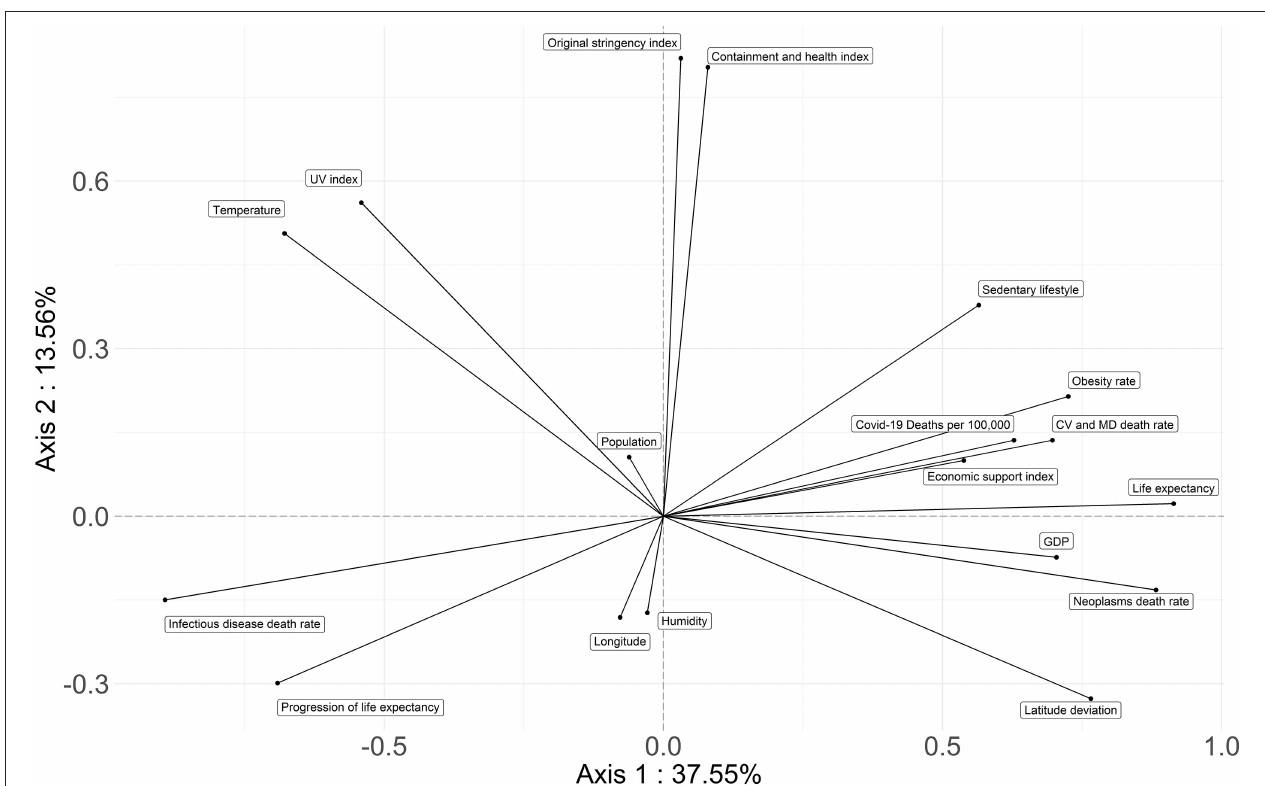
FIGURE 2 | PCA first factorial plane: axis 1 is horizontal; axis 2 is vertical. The more distant a variable is from the center, the more it is correlated with the first or the second factorial axis. The studied parameters regrouped the countries associated with Covid-19 highest death rates on the right of the horizontal axis. These are the high income countries with a high LE but a low progression of it, high sedentarity, obesity, high deviation from latitude 0 and low longitude (Asian countries have a high longitude, while it is negative in the Americas). Countries associated with low Covid-19 death rates have a low GDP, a low LE but a great margin of progression for it, a high prevalence of infectious diseases, a greater deviation from optimum temperature and UV index; they occupy the left part of the axis. Lockdown stringency, containment index and ambiant humidity are not correlated with Covid-19 mortality, as they are linked to the second axis. The cloud of individuals on the first factorial plane is presented in the Supplementary Figure 5